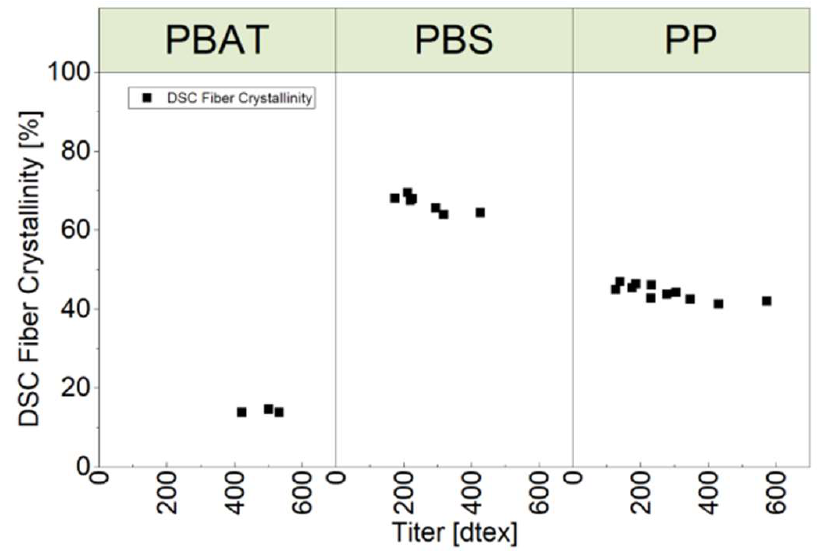
Figure 13. Crystallinity as a function of fiber fineness (titer in dtex) of three polymer fibers.